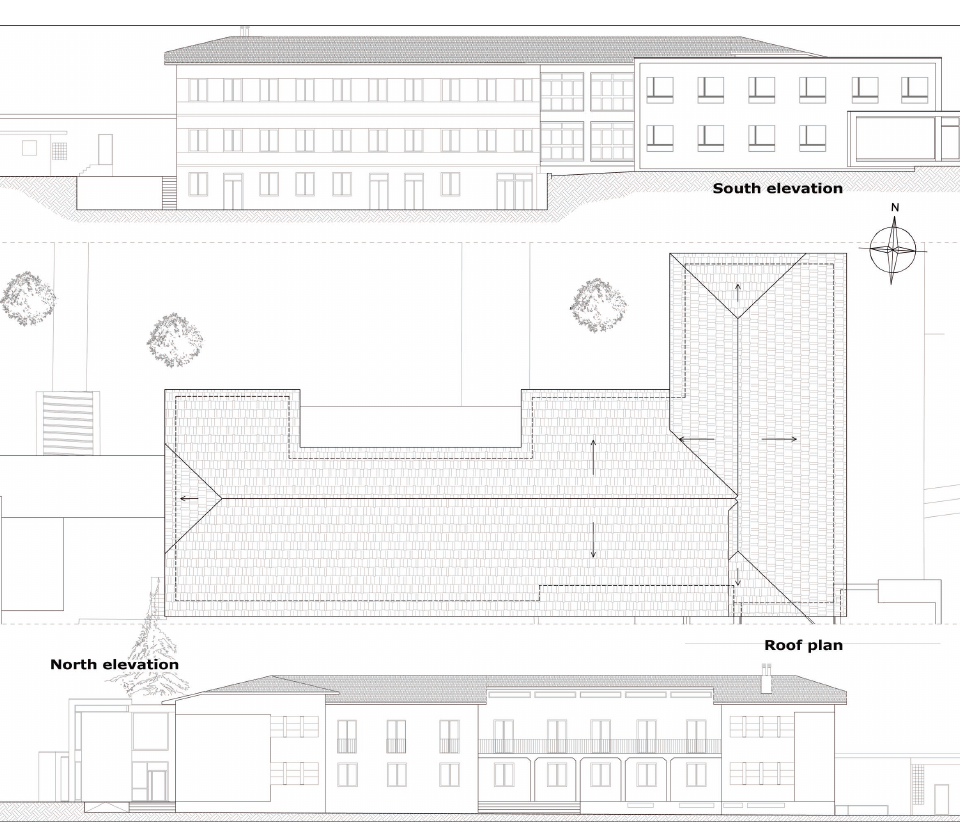
Fig. 1. The relief of the building’s roof plan and the main elevations useful to provide a general overview of the object of